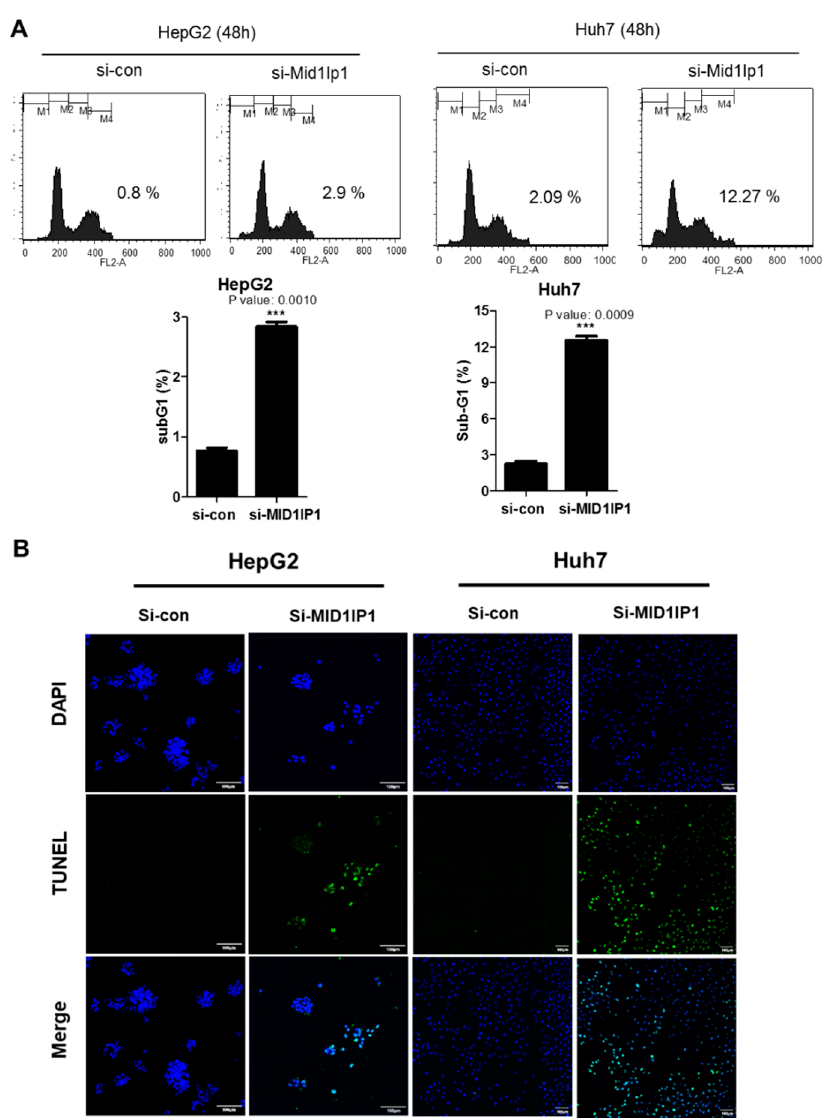
Figure 2. MID1IP1 depletion increases the sub G1 population and increases the number of TUNEL- positive cells in HepG2 and Huh7 cells. ( A ) Effect of MID1IP1 depletion on sub G1 population in HepG2 and Huh7 cells after 48 h culture by flow cytometric analysis. ( B ) Effect of MID1IP1